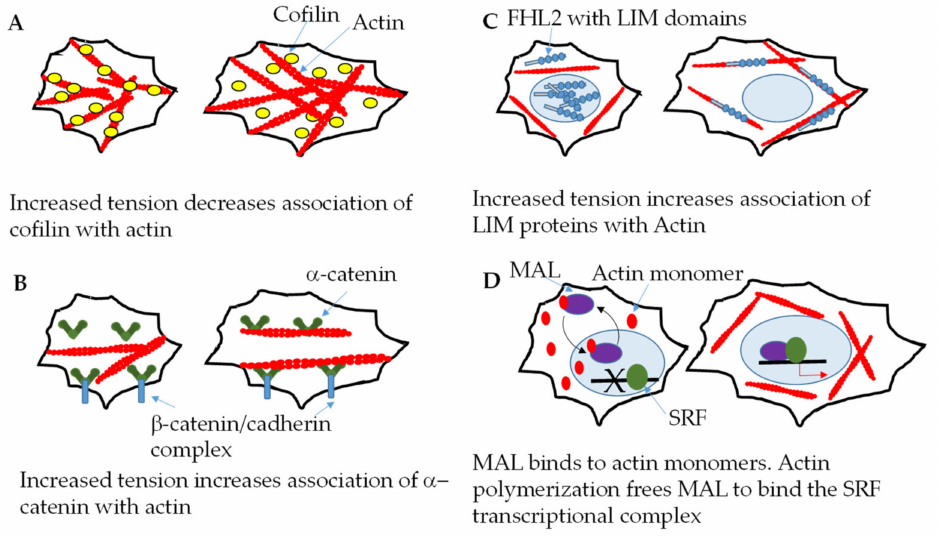
Figure 1. Examples of mechanosensing by actin filaments. ( A ) Increased tension of actin filaments decreases cofilin association, resulting in delayed actin filament severing. ( B ) Increased actin filament tension, within the cellular range, results in increase α -catenin binding either at the cell cortex or intracellularly. ( C ) Increased actin filament tension increases the binding of FHL2-containing proteins, excluding these proteins form the nucleus. ( D ) MAL binds to actin monomers in both the cytoplasm and the nucleus. Stimulation of cells with serum increases actin polymerization and decreases the availability of actin monomers. MAL then becomes available to bind to the SRF